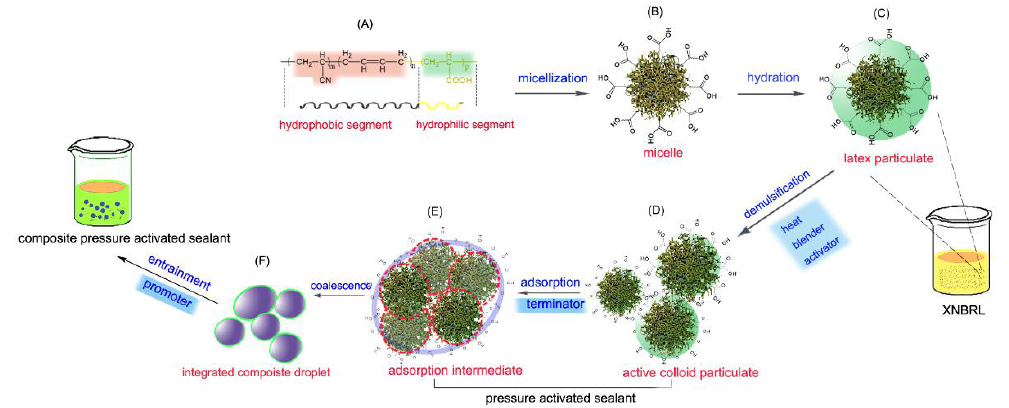
Figure 1. The process for the deterministic assembly of a three-dimensional (3D) mesostructure of central particulates in the preparation of a composite pressure-activated sealant. ( A ) Hydrophobic and hydrophilic segments of the XNBRL, ( B ) self-assembly of amphiphilic triblock copolymers into a 3D spherical micelle, ( C ) hydration shell formed by the adsorbed water, ( D ) shrinkage or breakage of the hydration shell caused by the brine, ( E ) flocculation of the active colloid particulates, and ( F ) coalescence of the intermediates into a complex 3D droplet.